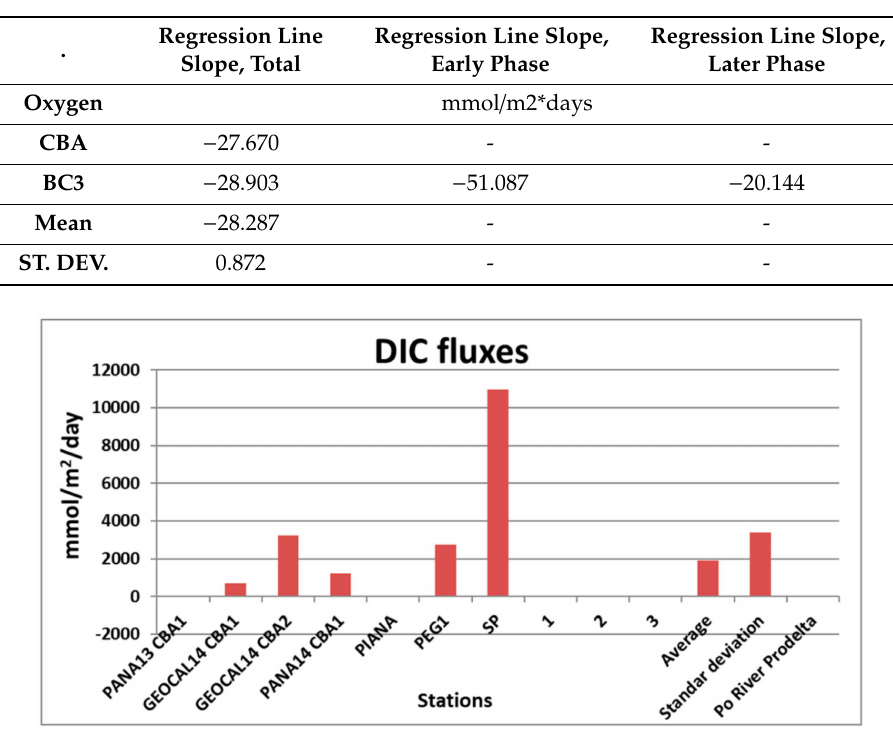
Table 2. Values of the oxygen fluxes at the sediment-water interface, calculated by the regression of all points (total), the phase with higher slope (early phase) and the lower slope (later phase).